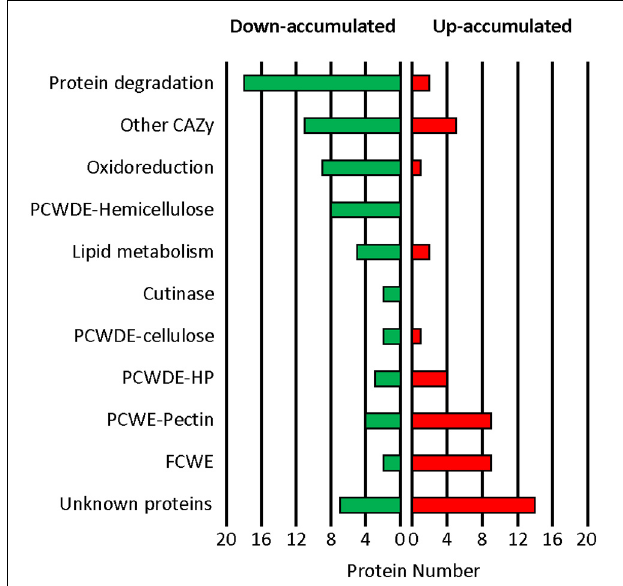
FIGURE 5 | Impact of the T2.16 mutation on the exo-proteome of B. cinerea. Functional categories classification of the secreted proteins that were down- or up-accumulated in comparison to the parental control (B05.10) (fold change > 2), (see Supplementary Table 2 for details). The parental and the T2.16 mutant strains were grown for 3 days in liquid CCPX medium (three independent biological experiments) and a comparative shotgun proteomic analysis was performed on the proteins collected from the cultures supernatants. CAZy, carbohydrate active enzymes; PCWDE, plant cell wall degrading enzymes; HP, Hemicellulose-Pectin; FCWE, fungal cell wall